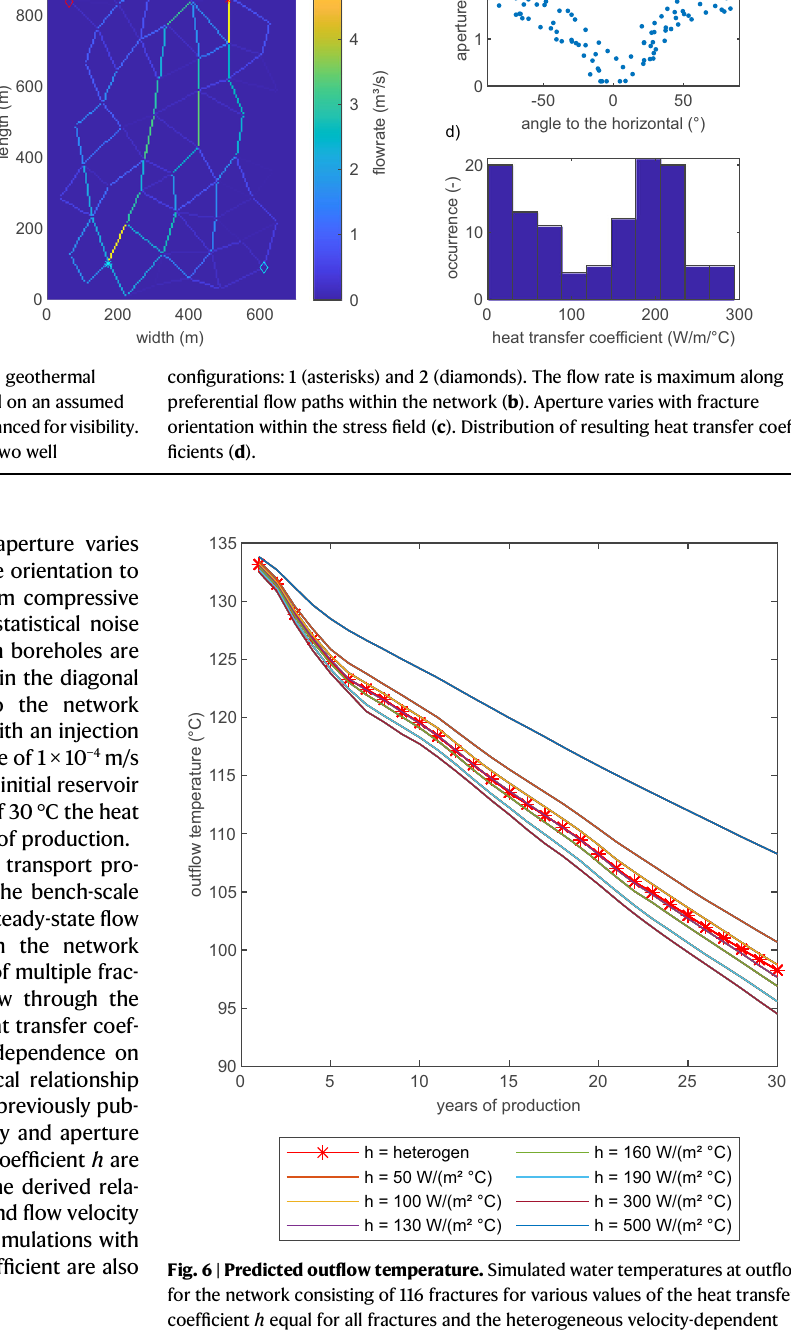
Fig. 6 | Predicted out fl owtemperature. Simulated watertemperatures at out fl ow for the network consisting of 116 fractures for various values of the heat transfer coef fi cient h equal for all fractures and the heterogeneous velocity-dependent